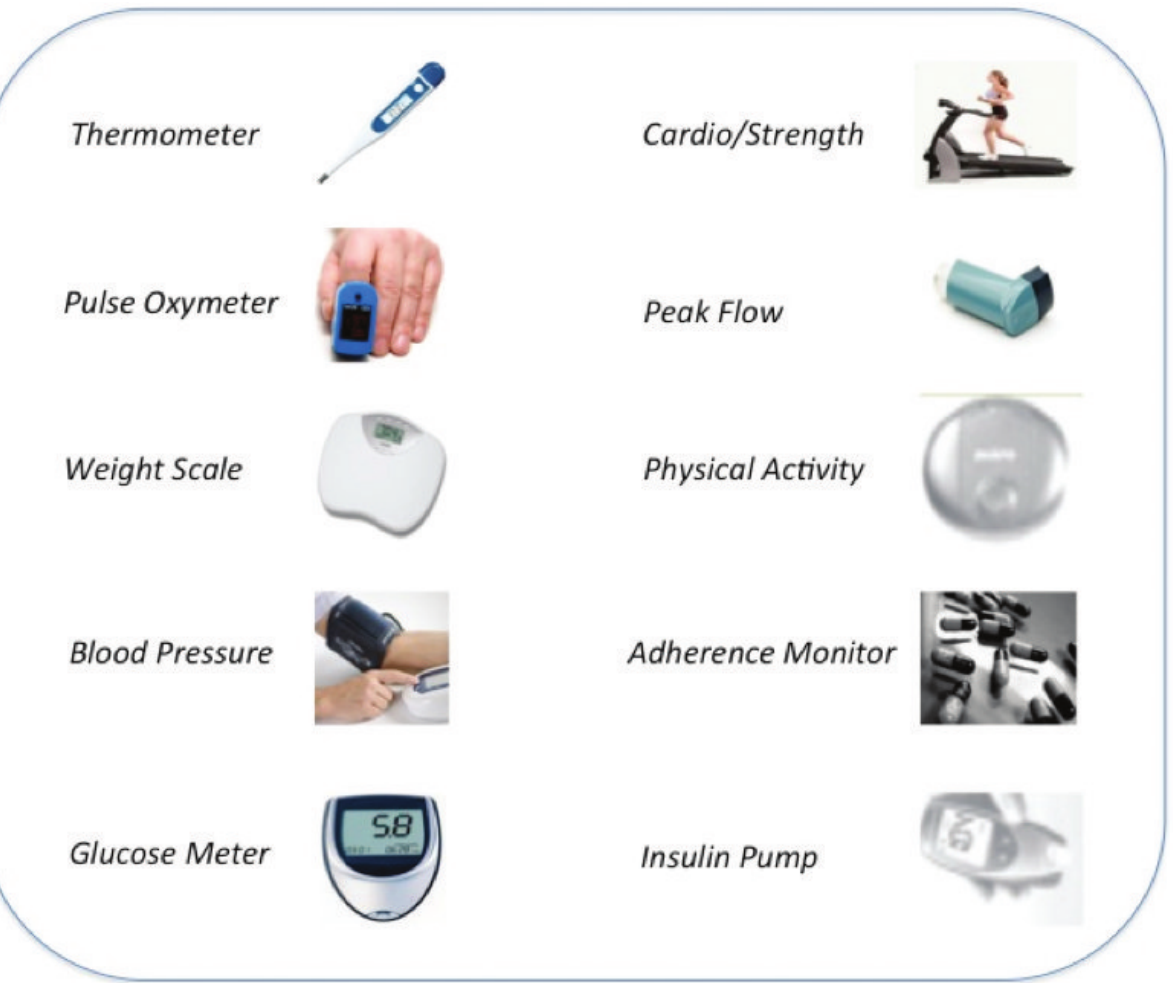
Figure 2. Examples of personal biomedical devices (Source: Continua Health Alliance